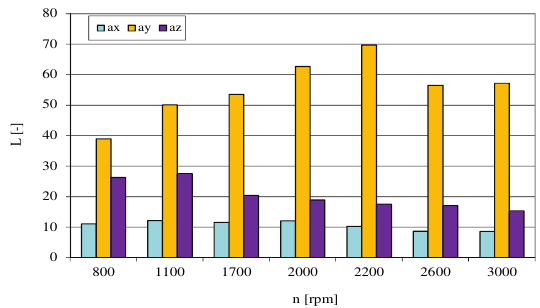
Fig. 10. Clearance coefficient of vibration accelerations for X, Y and Z dimensions and different engine